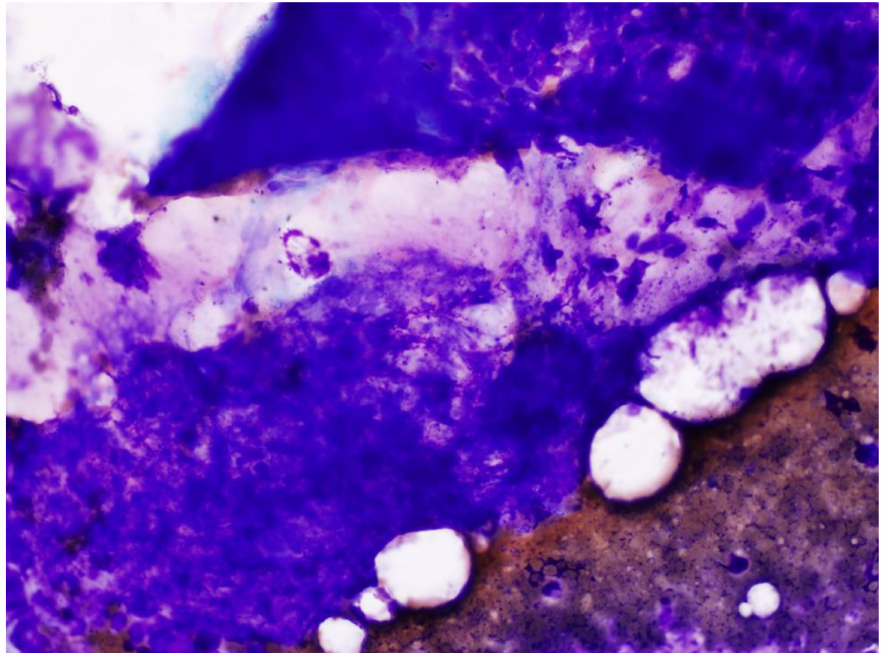
Figure 1. Smear preparation characterized by crush artifact and debris-obscuring cellular detail to a degree that no diagnosis can be made (Diff–Quik